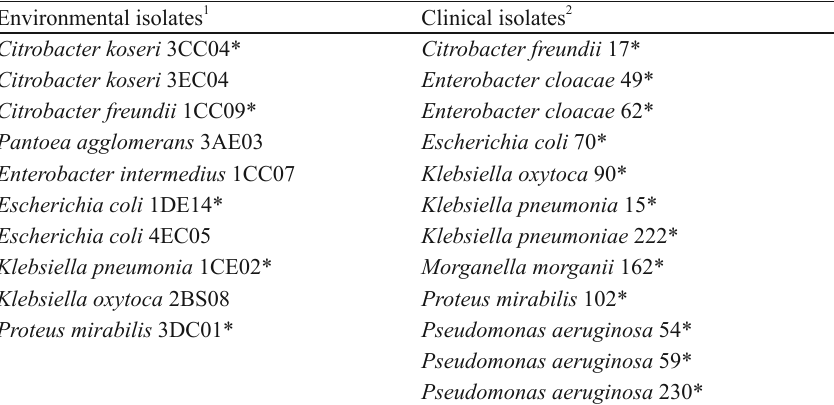
G ram-negative bacteria used in this